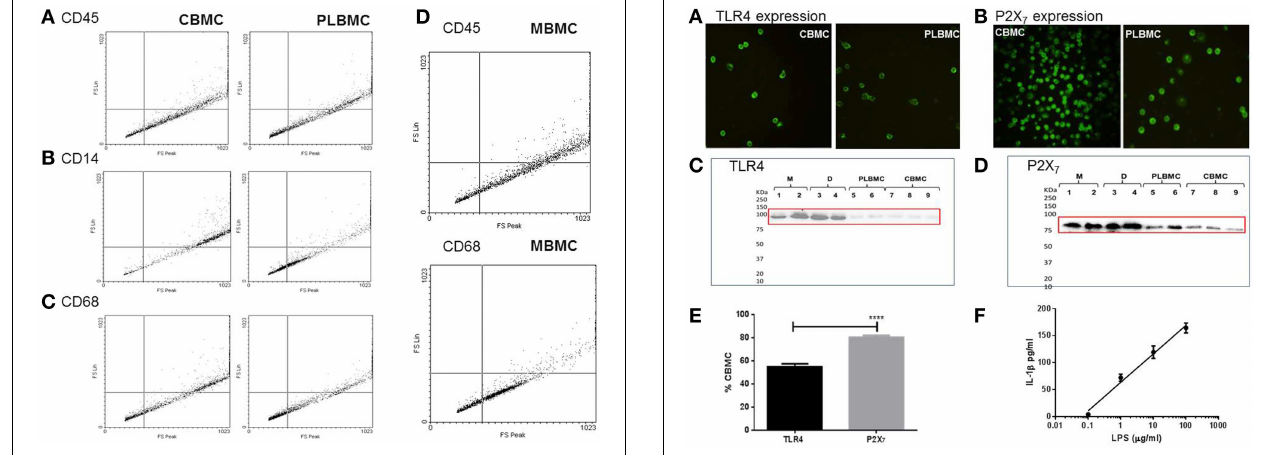
FIGURE 3 | Expression of TLR4 and P2X 7 proteins in gestational tissues. (A) CBMCs and PLBMCs express TLR4 (anti-TLR4 antibody at 1:200); (B) CBMCs and PLBMCs express the P2X 7 receptor (anti-P2X 7 antibody at 1:200). Immunofluorescence was detected